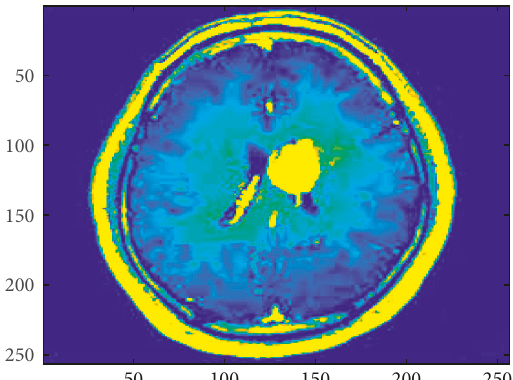
Figure 4: Mesh grid PSD.